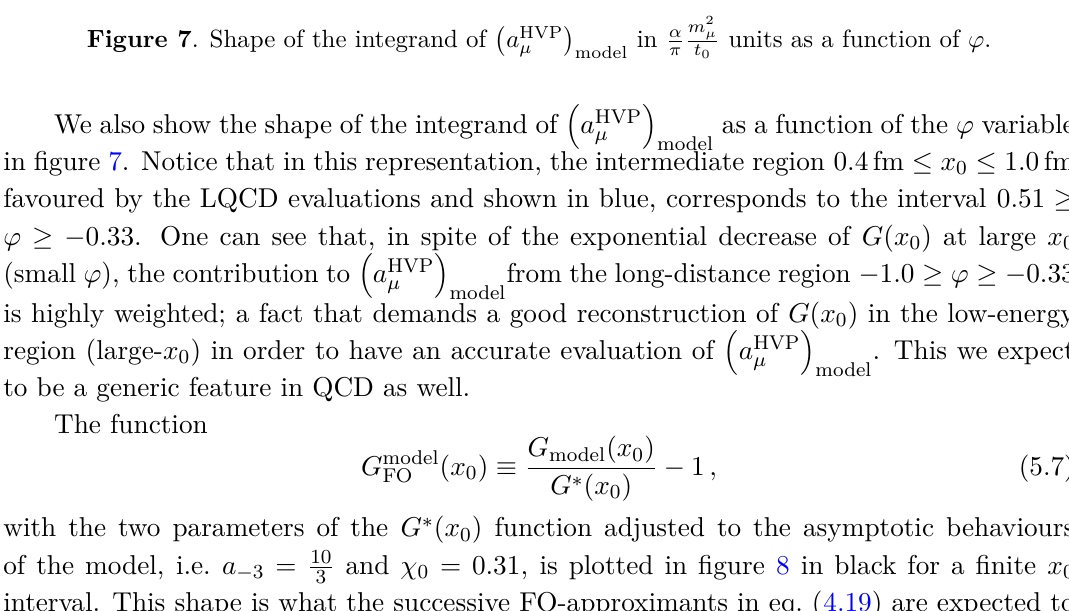
Figure 7 . Shape of the integrand of